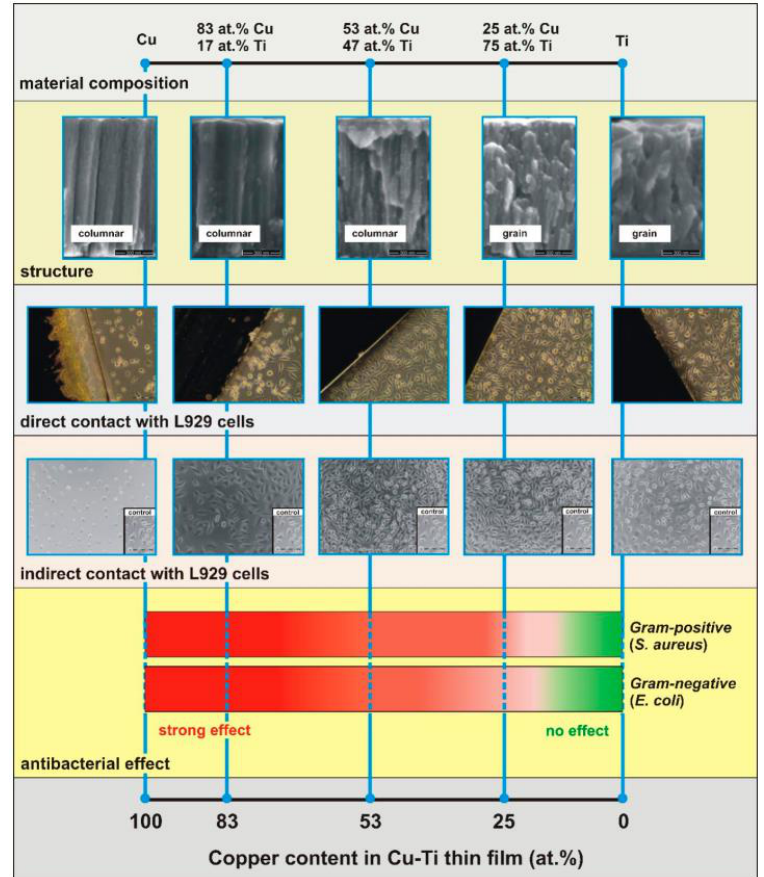
Figure 8. The influence of material composition on the biological properties of nanocrystalline thin films based on Cu and Ti. Reproduced with permission from Ref. [114]. Copyright 2020, Multidisciplinary Digital Publishing Institute.